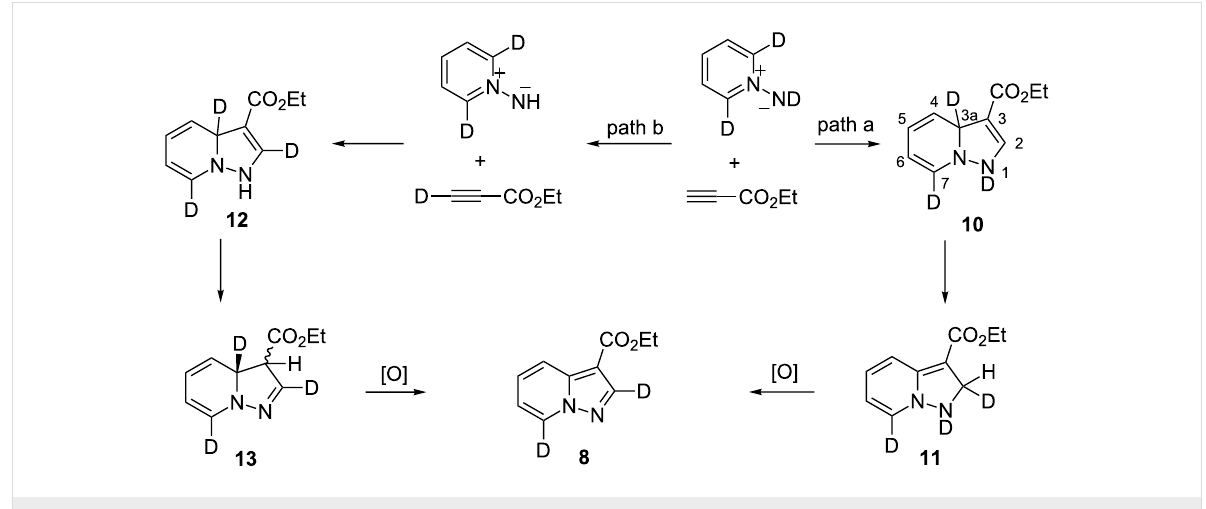
Scheme 2: Possible pathways for the formation of 8